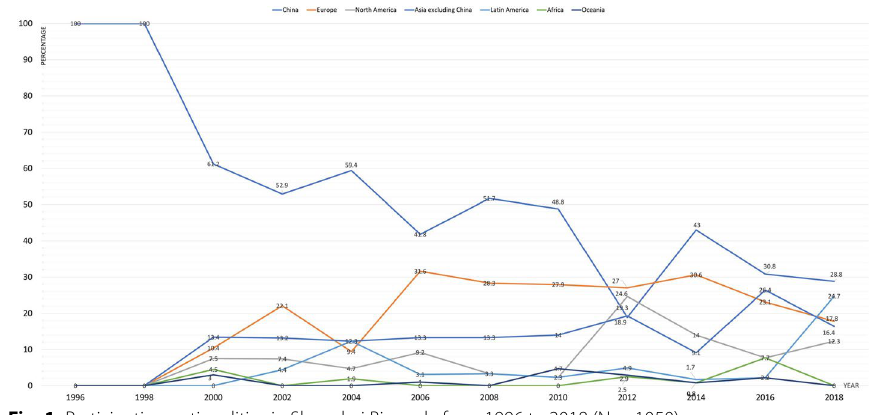
Fig. 1 Participating nationalities in Shanghai Biennale from 1996 to 2018 (N